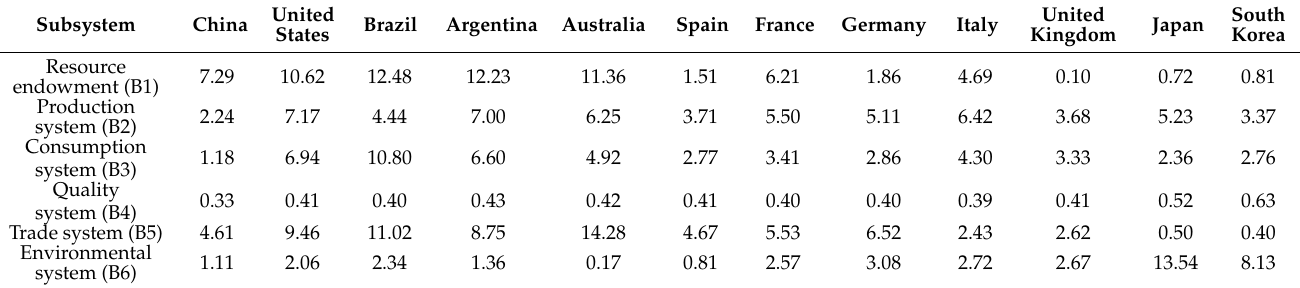
Table 3. Comparison of the development level of the subsystems in the beef cattle industry among the representative countries.